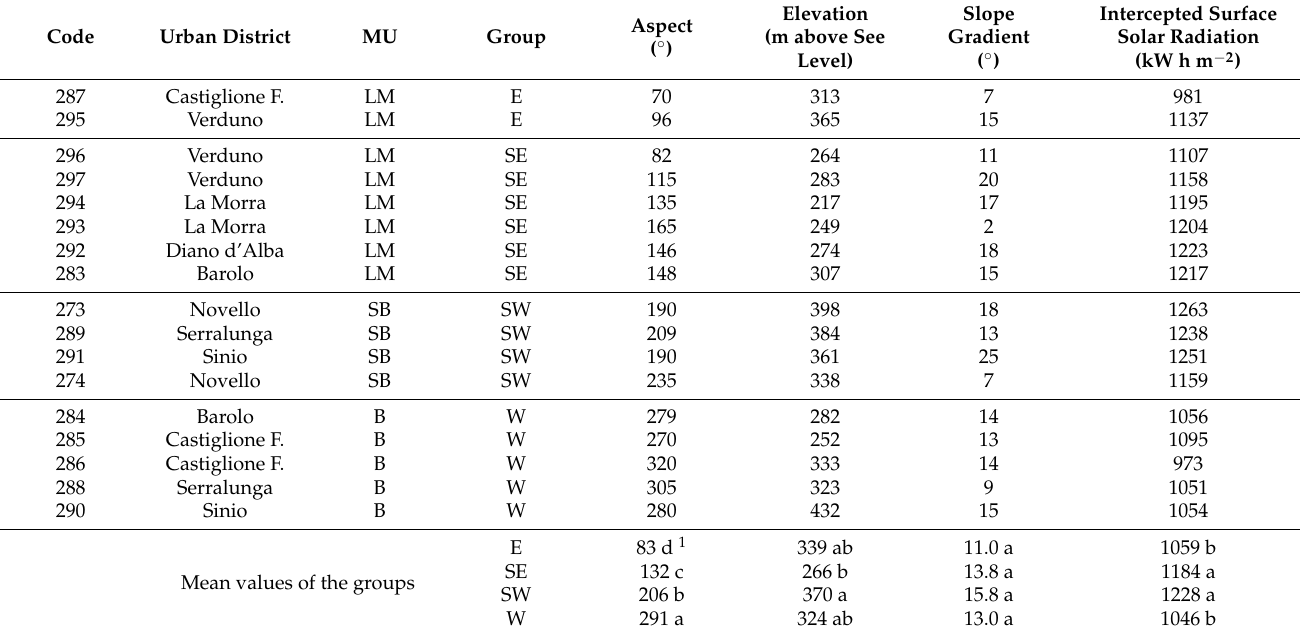
Table 1. Vineyard codes, urban district, mesoclimatic unit (MU), group membership obtained by cluster analysis, and main topographic features of the vineyards investigated; average values were calculated for each group.